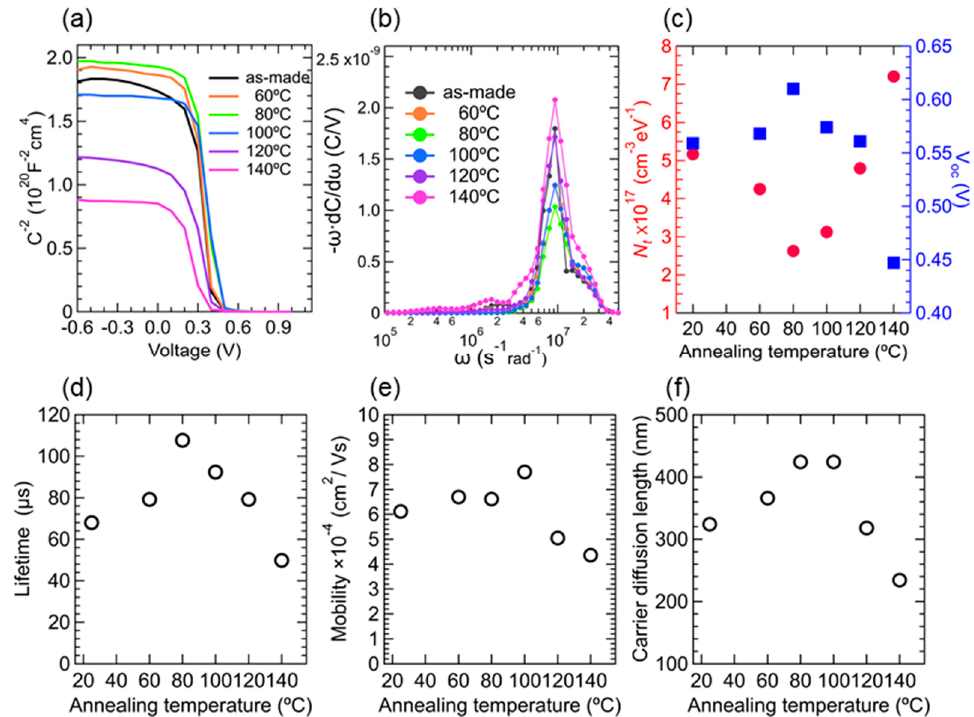
Figure 4. ( a ) A Mott–Schottky plot of the solar cells, ( b ) The −ω dC / d ω versus ω plots of the pristine solar cell and annealed cells. ( c ) Annealing temperature dependence of defect density, ( d ) lifetime, ( e ) carrier mobility and ( f ) carrier diffusion length.